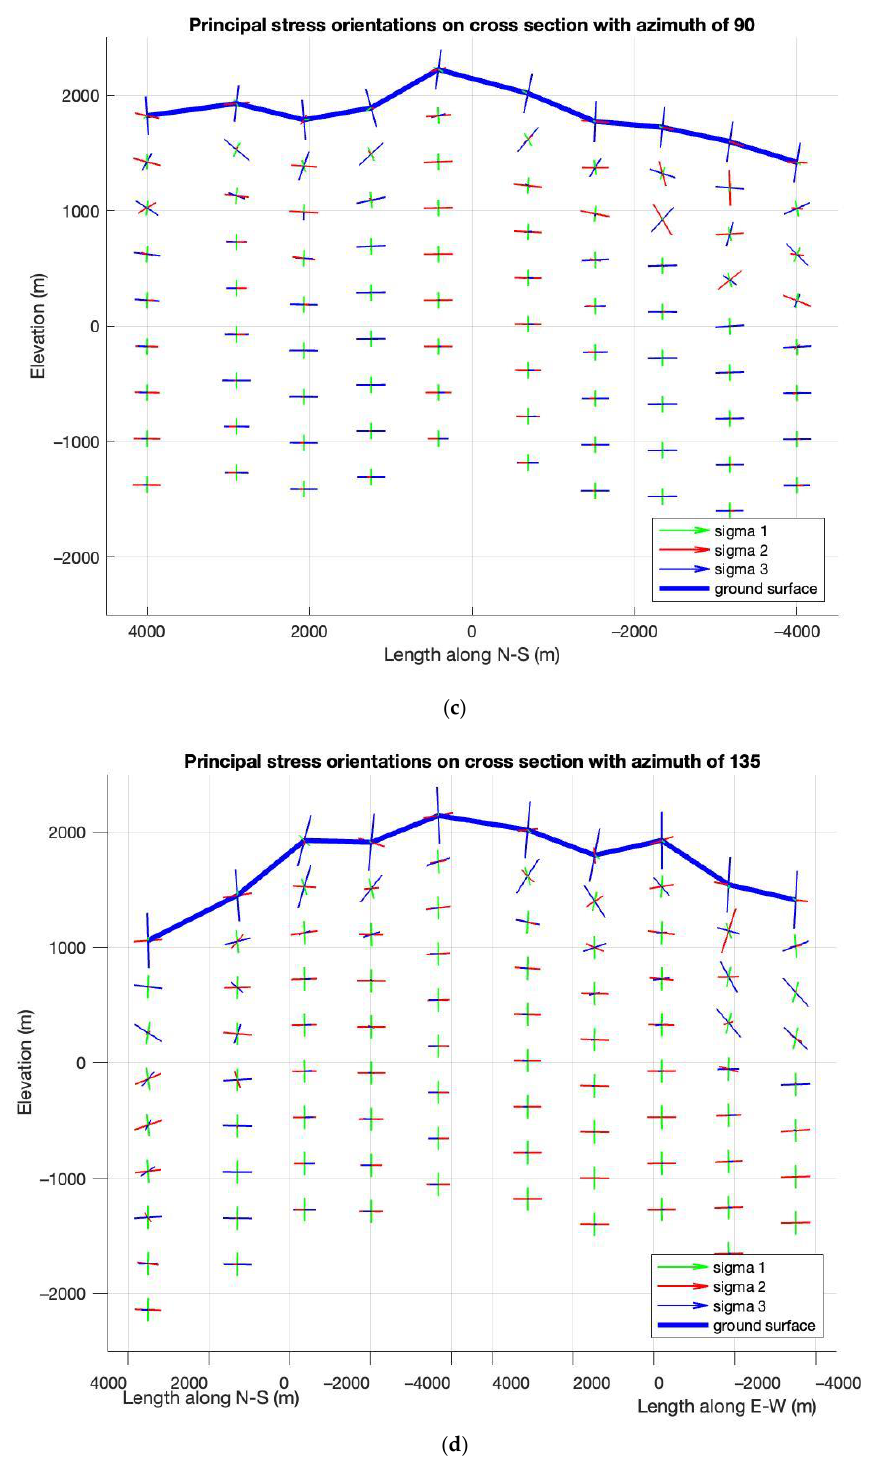
Figure 7. Orientation of principal stresses without tectonic stress in cross-section views with varying azimuth. ( a ) E-W; ( b ) NW-SW; ( c ) N-S; ( d ) NW-SE. All plots are drawn with unit vectors to represent the direction; the length is irrelevant to the magnitude. Locations of the cross sections are shown in Figure 5b.